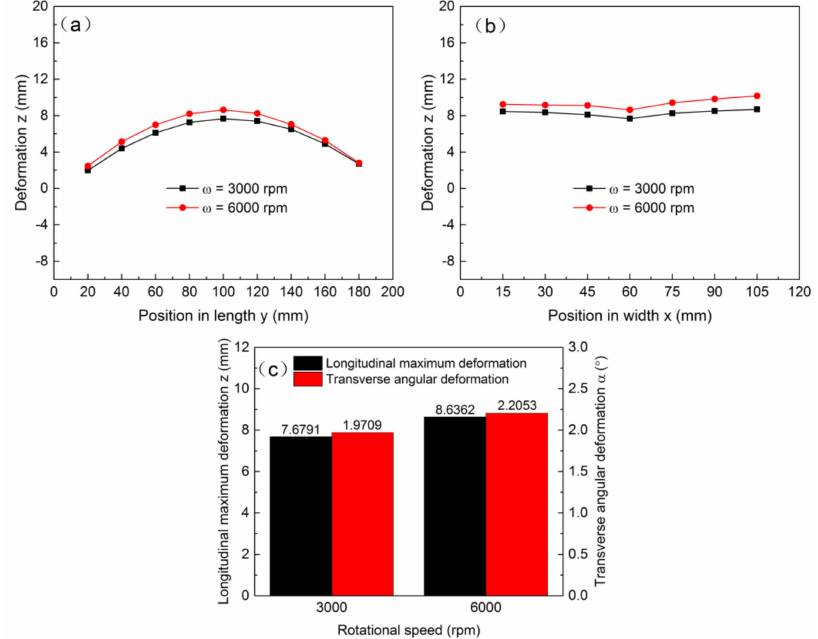
Figure 9. Deformation comparison for di ff erent rotational speeds: ( a ) in longitudinal direction at position x = 0, ( b ) in transverse direction at position y = 100 mm, and ( c ) longitudinal maximum bending deformation and transverse angular